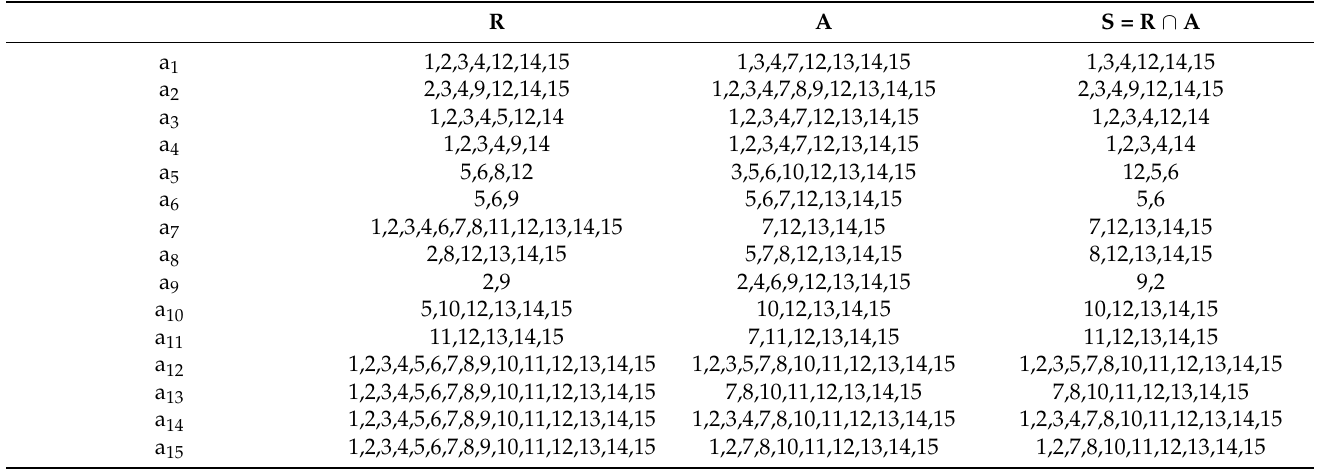
Table A2. Decomposition of influencing factors